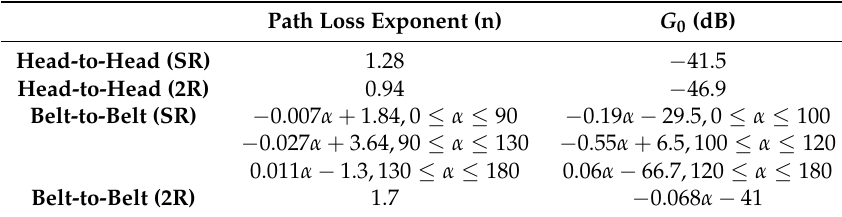
Table 4. Examples of parametrization of the path loss in a single-room (SR) or two-room (2R) scenario for head-to-head and belt-to-belt